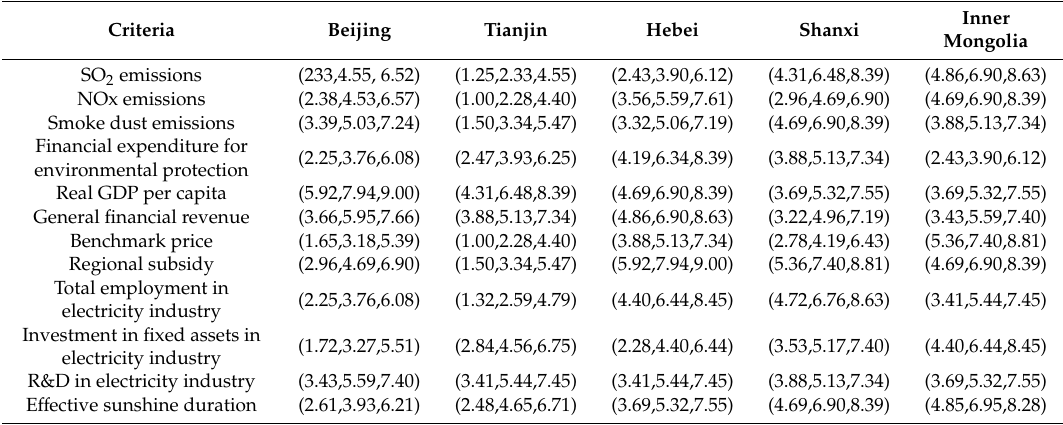
Table A5. The fuzzy estimation of 30 regions on 12